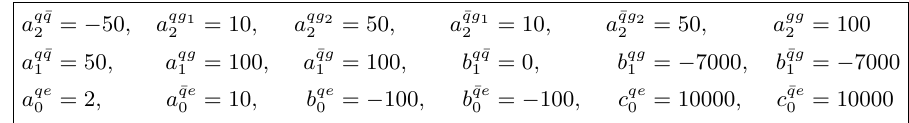
Table 5 . Values of the coefficients a , b and c used in eqs. (3.2), (3.4) and